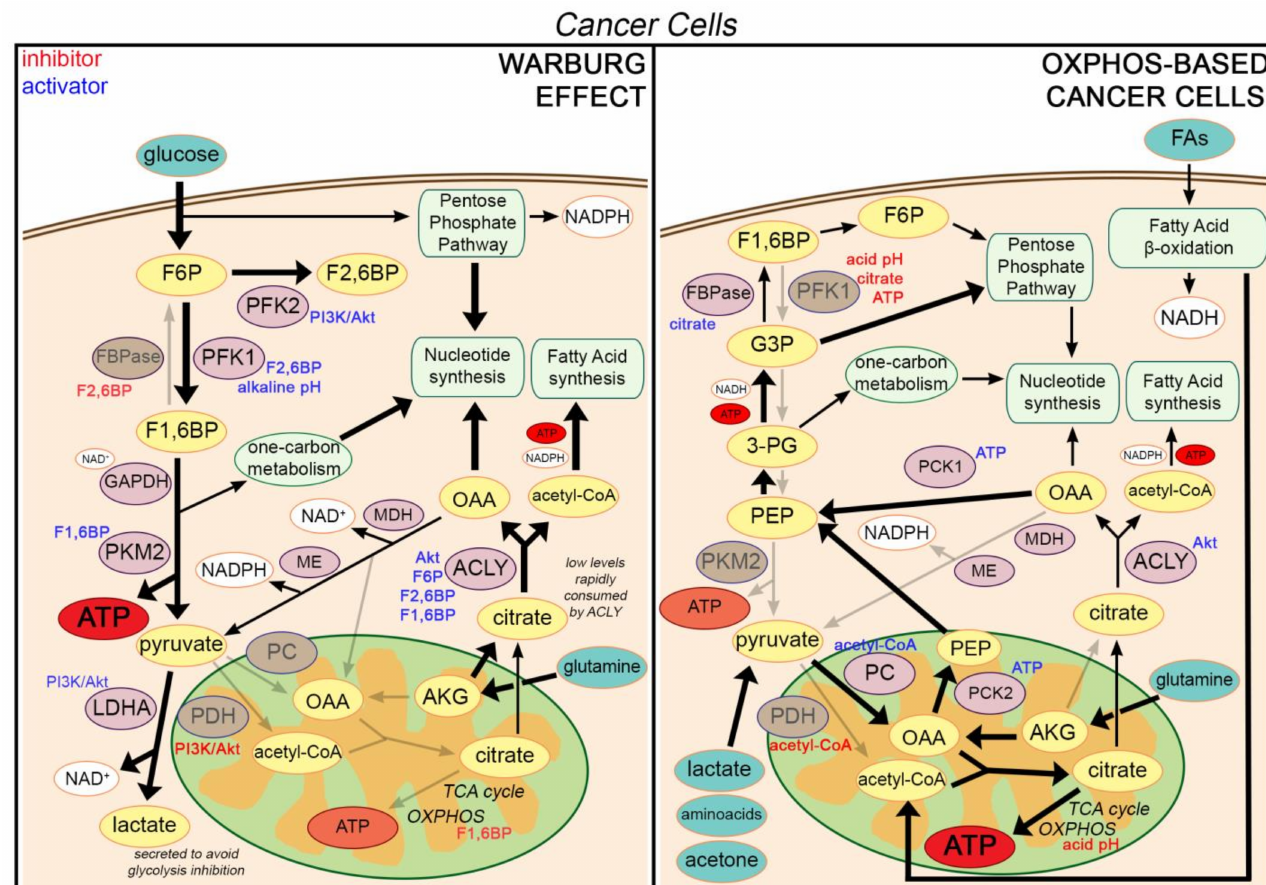
Figure 1. Citrate fate in cancer cells. Enzymes are indicated in pink (active) or brown (inactive). Metabolites are in yellow (intracellular) or green (when uptaken from the extracellular environment). Key cellular processes are in light green. Specific regulators of protein activities are indicated in blue (activators) or red (inhibitors). Arrow size is proportional to pathway engagement (in gray if the pathway is not active). Differences in glycolytic and mitochondrial ATP production are highlighted using a different font size. Small ATP and NAD(P)H boxes (not originating from an arrow) indicate their requirement to sustain the corresponding cellular processes (FAS from acetyl-CoA, 3-PG to G3P conversion, and GAPDH activity). On the left side, the functioning of cells relying on the Warburg effect is summarized. Glucose is channelled into glycolysis to produce ATP. Moreover, a portion of glycolytic intermediates is diverted toward the PPP and the serine one-carbon metabolism to sustain nucleotide synthesis. Since pyruvate is preferentially transformed by LDHA into lactate (with regeneration of NAD + required for GAPDH functioning), it poorly supports the generation of citrate from acetyl-CoA and OAA in mitochondria. Consequently, citrate can be derived mainly from glutamine via AKG. Moreover, citrate is rapidly converted by ACLY into OAA (sustaining nucleotide synthesis and/or being recycled into malate and pyruvate)